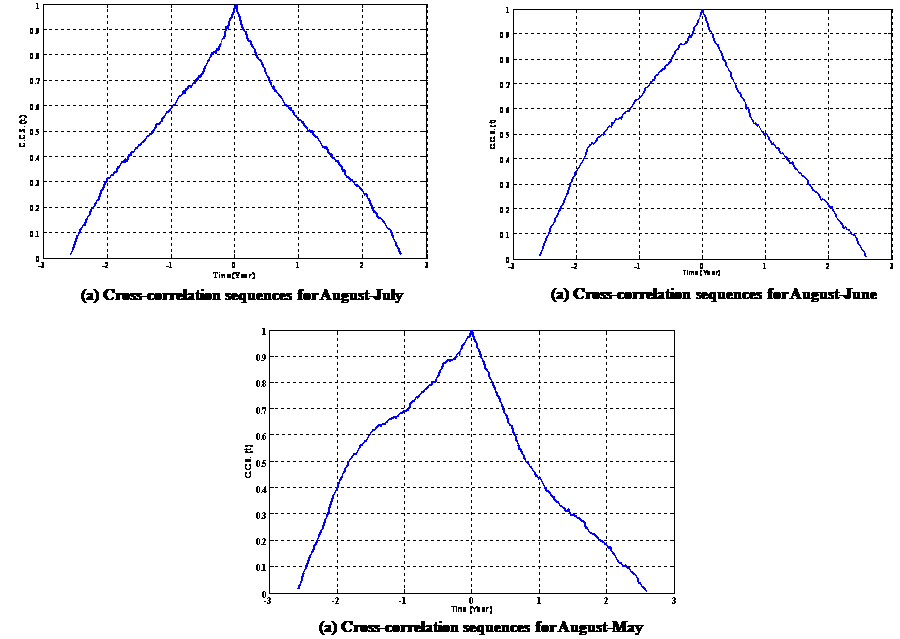
Fig. (3). The cross-correlation sequence for the inflow for months of Fig. 3. The cross-correlation sequence for the inflow for months of (August–July, August–June, August–May). ∗ C.C.S. ( t ) represents the cross-correlation sequence of the two variables (Brown and Hawng, 1997). * C.C.S. (t) represents the cross correlation sequence of the two variables (Brown and Hawng 1997)